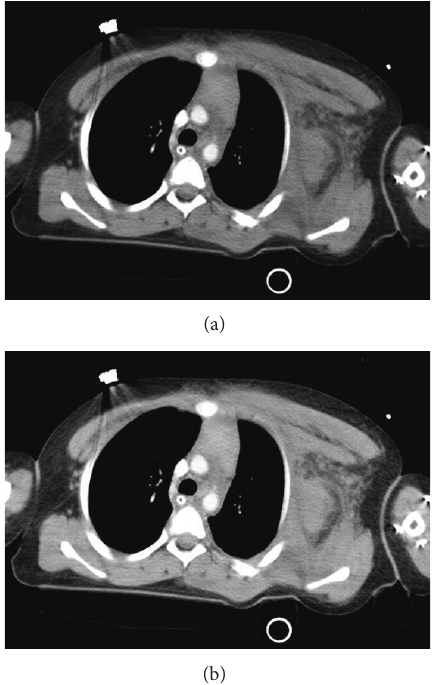
Figure 3: CT scan of the chest shows left apical pulmonary contusion with soft tissue edema, subcutaneous fat infiltrations, and muscular thickening with gas in the subclavicular space.